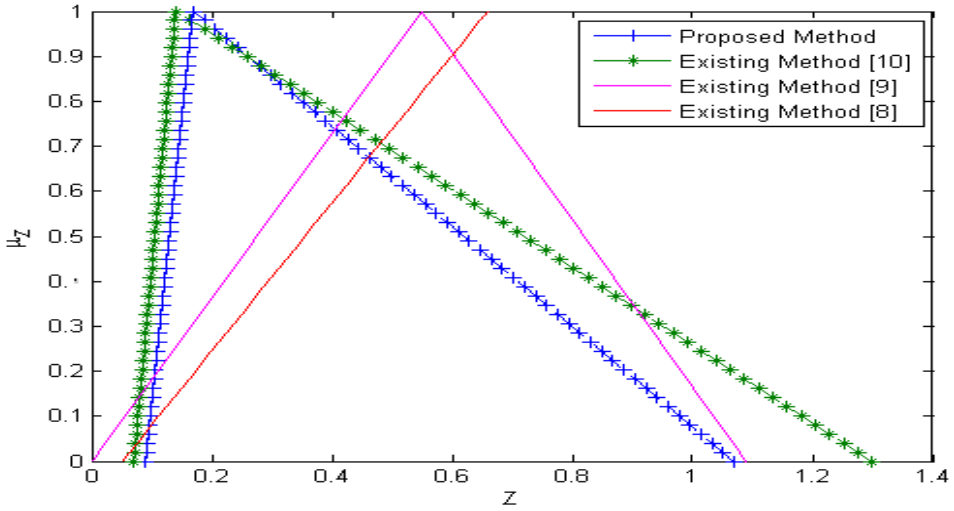
Figure 1. Membership function of the proposed method vs existing methods